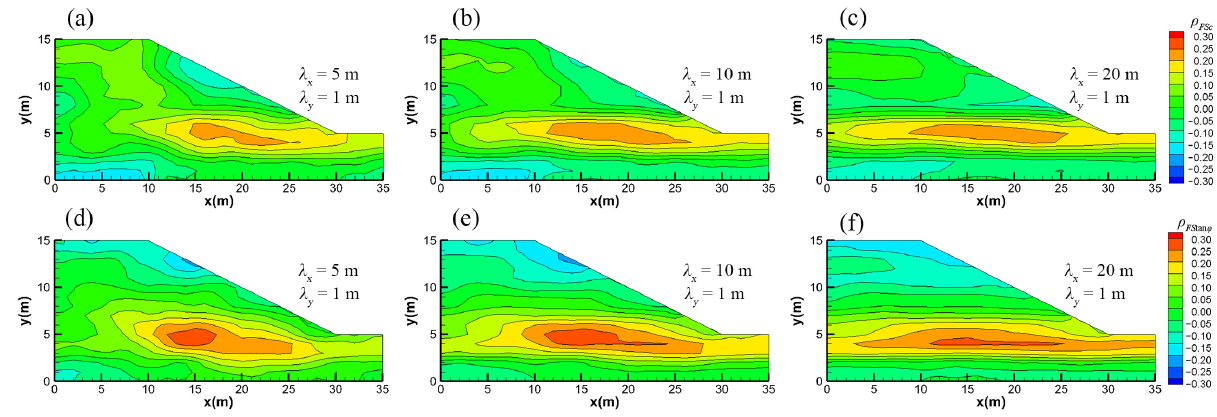
Figure 5. Cross ‐ correlation maps of FS and c ( a – c ) and tan φ ( d – f ) under three different horizontal Figure 5. Cross-correlation maps of FS and c ( a – c ) and tan ϕ ( d – f ) under three different horizontal statistical anisotropic correlation scales. statistical anisotropic correlation scales.